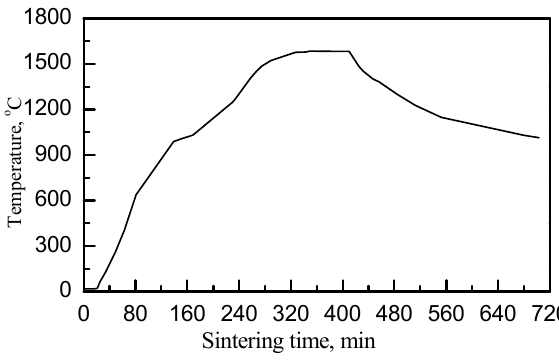
Figure 1. Sintering temperature vs. time for 51Fe-39Ni- 10Al 2 O 3 anode.